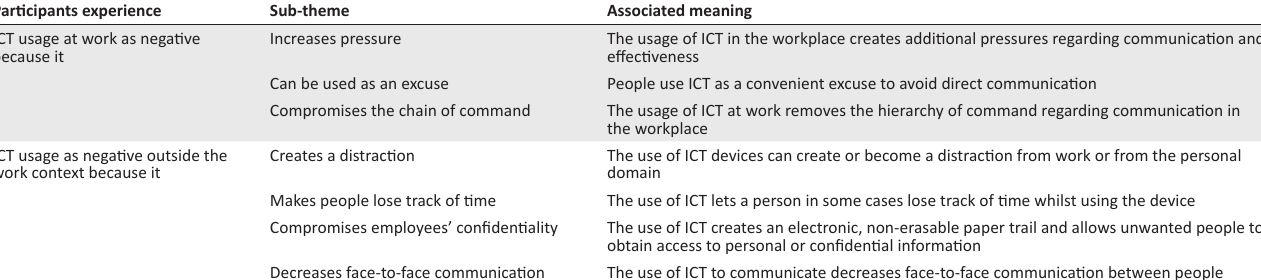
TABLE 2: Theme 2: Negative experiences of ICT. Participants